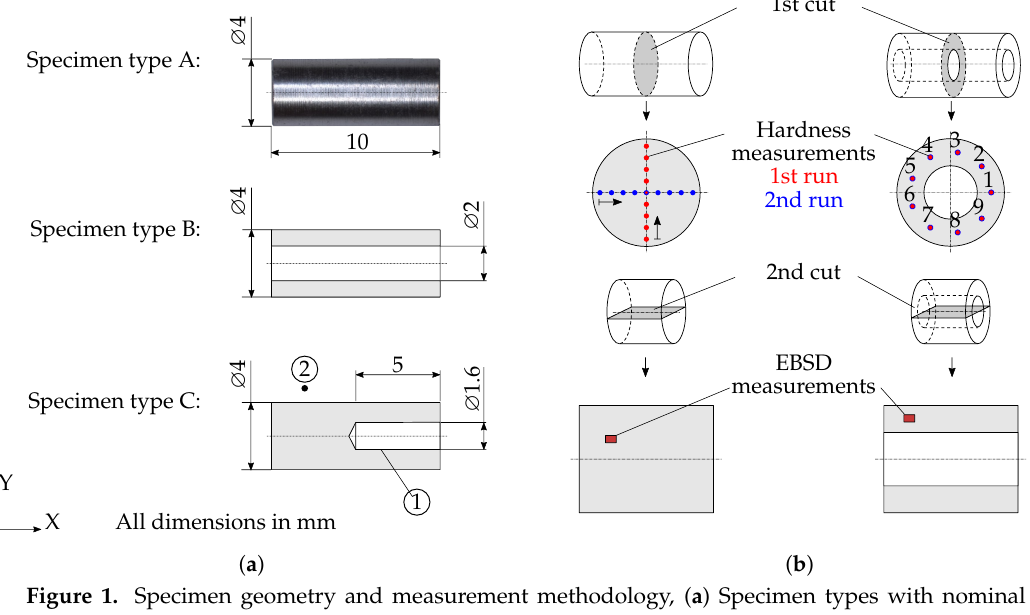
Figure 1. Specimen geometry and measurement methodology, ( a ) Specimen types with nominal dimensions of material 50CrMo4 (SAE4150); specimen type C is only used for temperature measurement. ( b ) Specimen handling after heat treatment. EBSD: electron backscatter